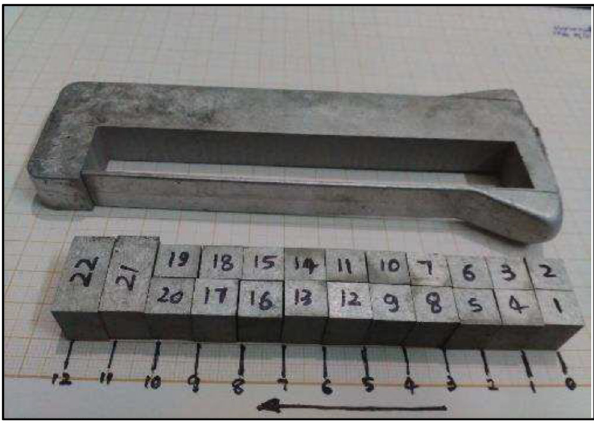
Fig. 6. Casting cut specimens for checking the uniformity of hardness in